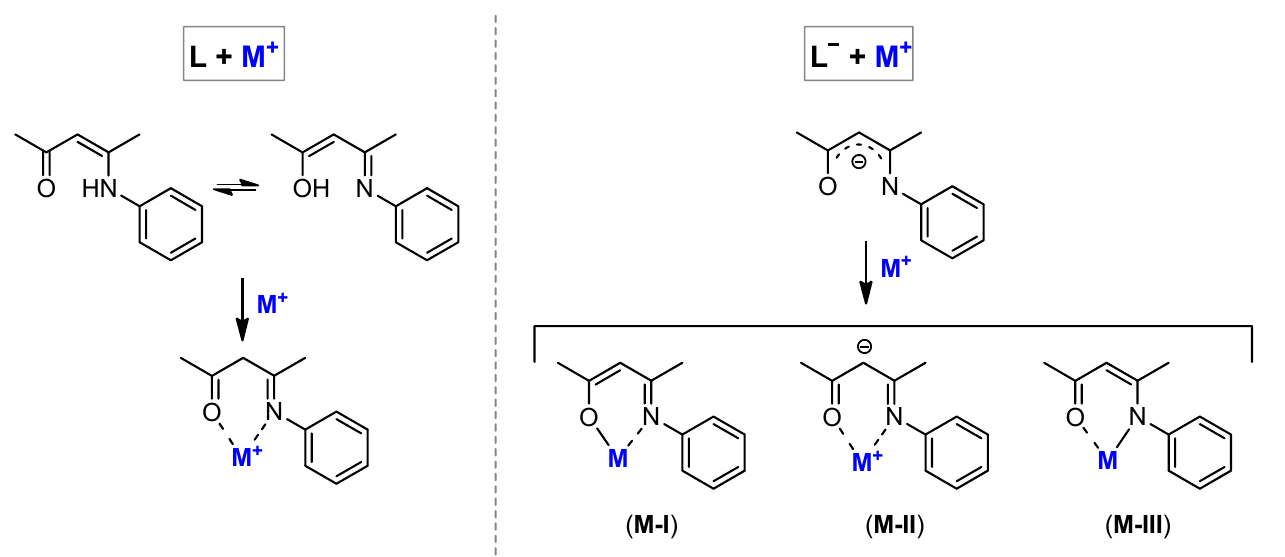
Scheme 2. Schematic representation of the ligand, both in the neutral ( L , left) and in the deprotonated ( L – , right) form, chelating a metal M + . For simplicity, additional ligands and/or halogens in the metal coordination sphere are omitted.